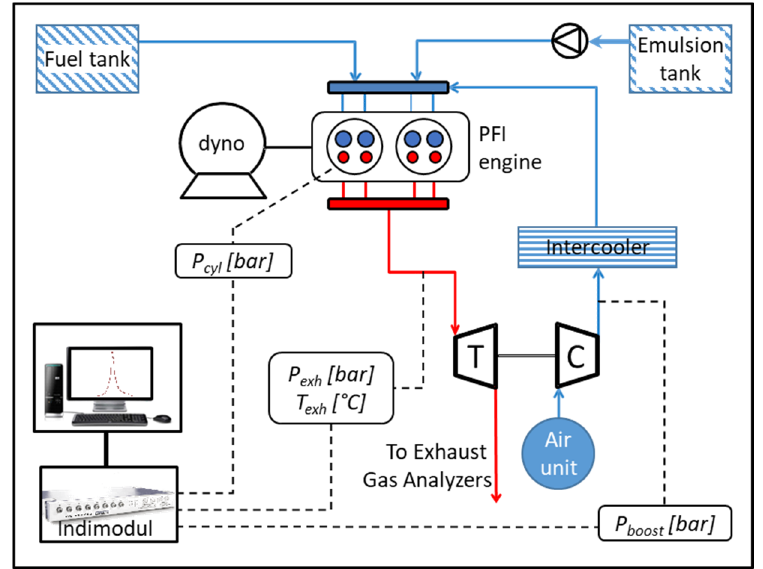
Figure 1. General layout of the experimental setup.